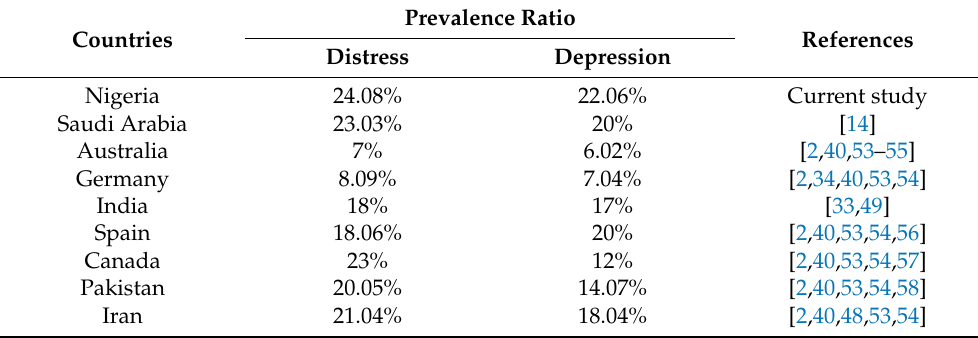
Table 6. Prevalence comparison of the current study with previous